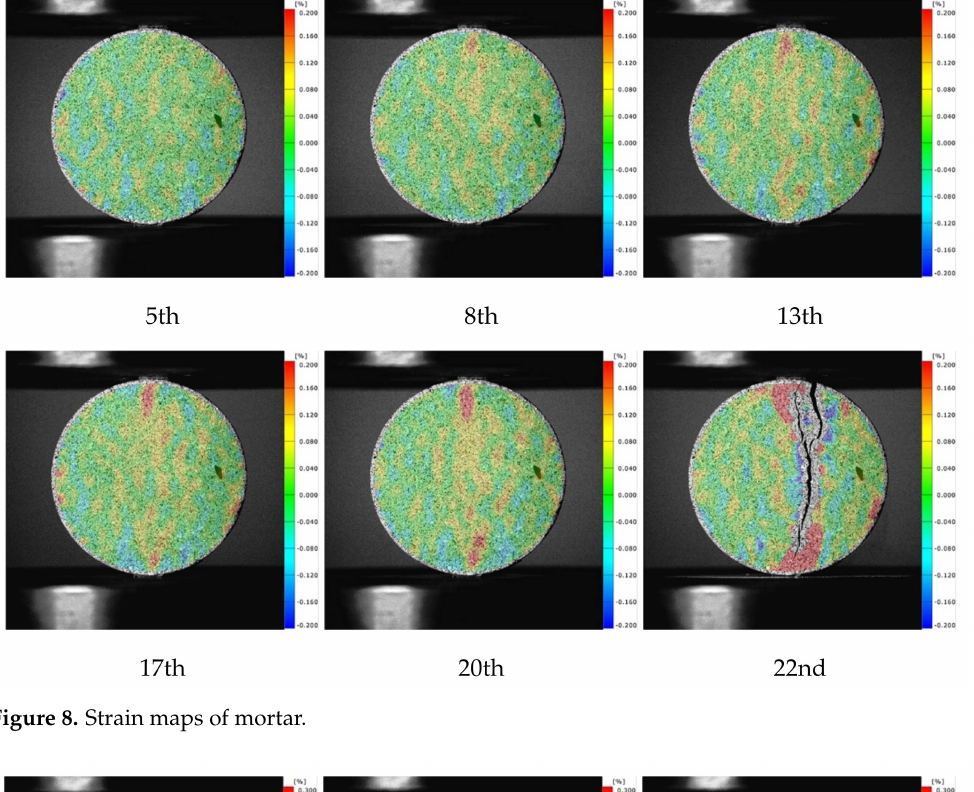
Figure 8. Strain maps of mortar.